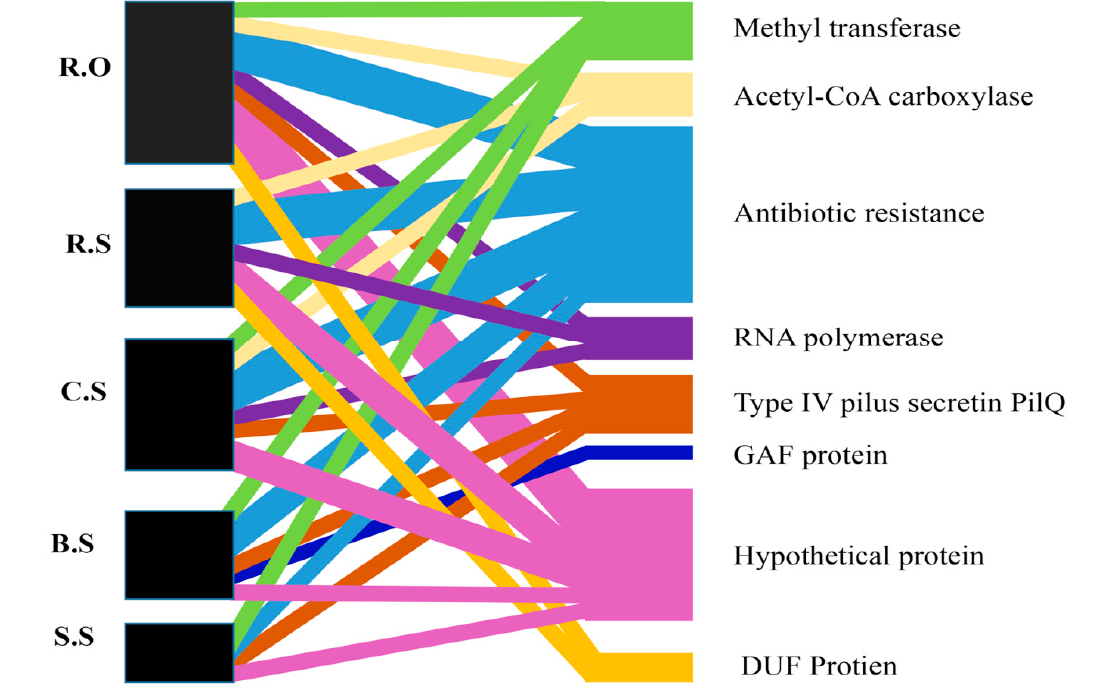
Figure 3. The shared gene cassette networks among the sites. The black box on the left side shows the sites, and the box’s horizontal width shows the different proteins in that site. The various colors on the right side of the figure represent the different gene cassette proteins. The crossed lines of various colors between the two blocks show the presence of a specific protein, and the width of the line shows that protein’s concentration in that specific site. R.O—agriculture runoff site, R.S—rice field site, C.S—citrus field site, S.S—sugarcane field site, B.S—banana field site. The line represents the association between various sites, while the different colors represent the various GCs.